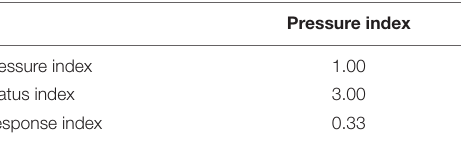
TABLE 1 | Relative importance judgment matrix and ranking.